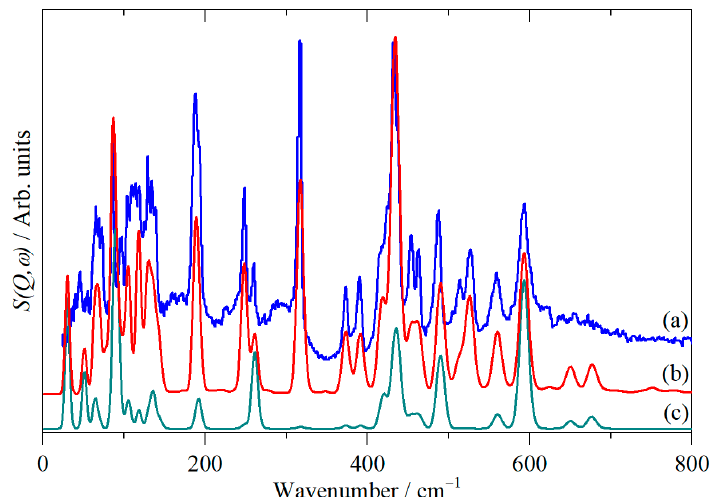
Figure 4. Comparison of observed and calculated INS spectra of Fe 2 (CO) 9 . ( a ) Experimental, ( b ) gen- erated from a periodic-DFT calculation of the complete unit cell at the Brillouin zone Γ -point after adjustment of the modes for the best fit and ( c ) as ( b ) but showing only the modes that involve motion of the iron atoms. ( c ) is × 5 ordinate expanded relative to ( b ).